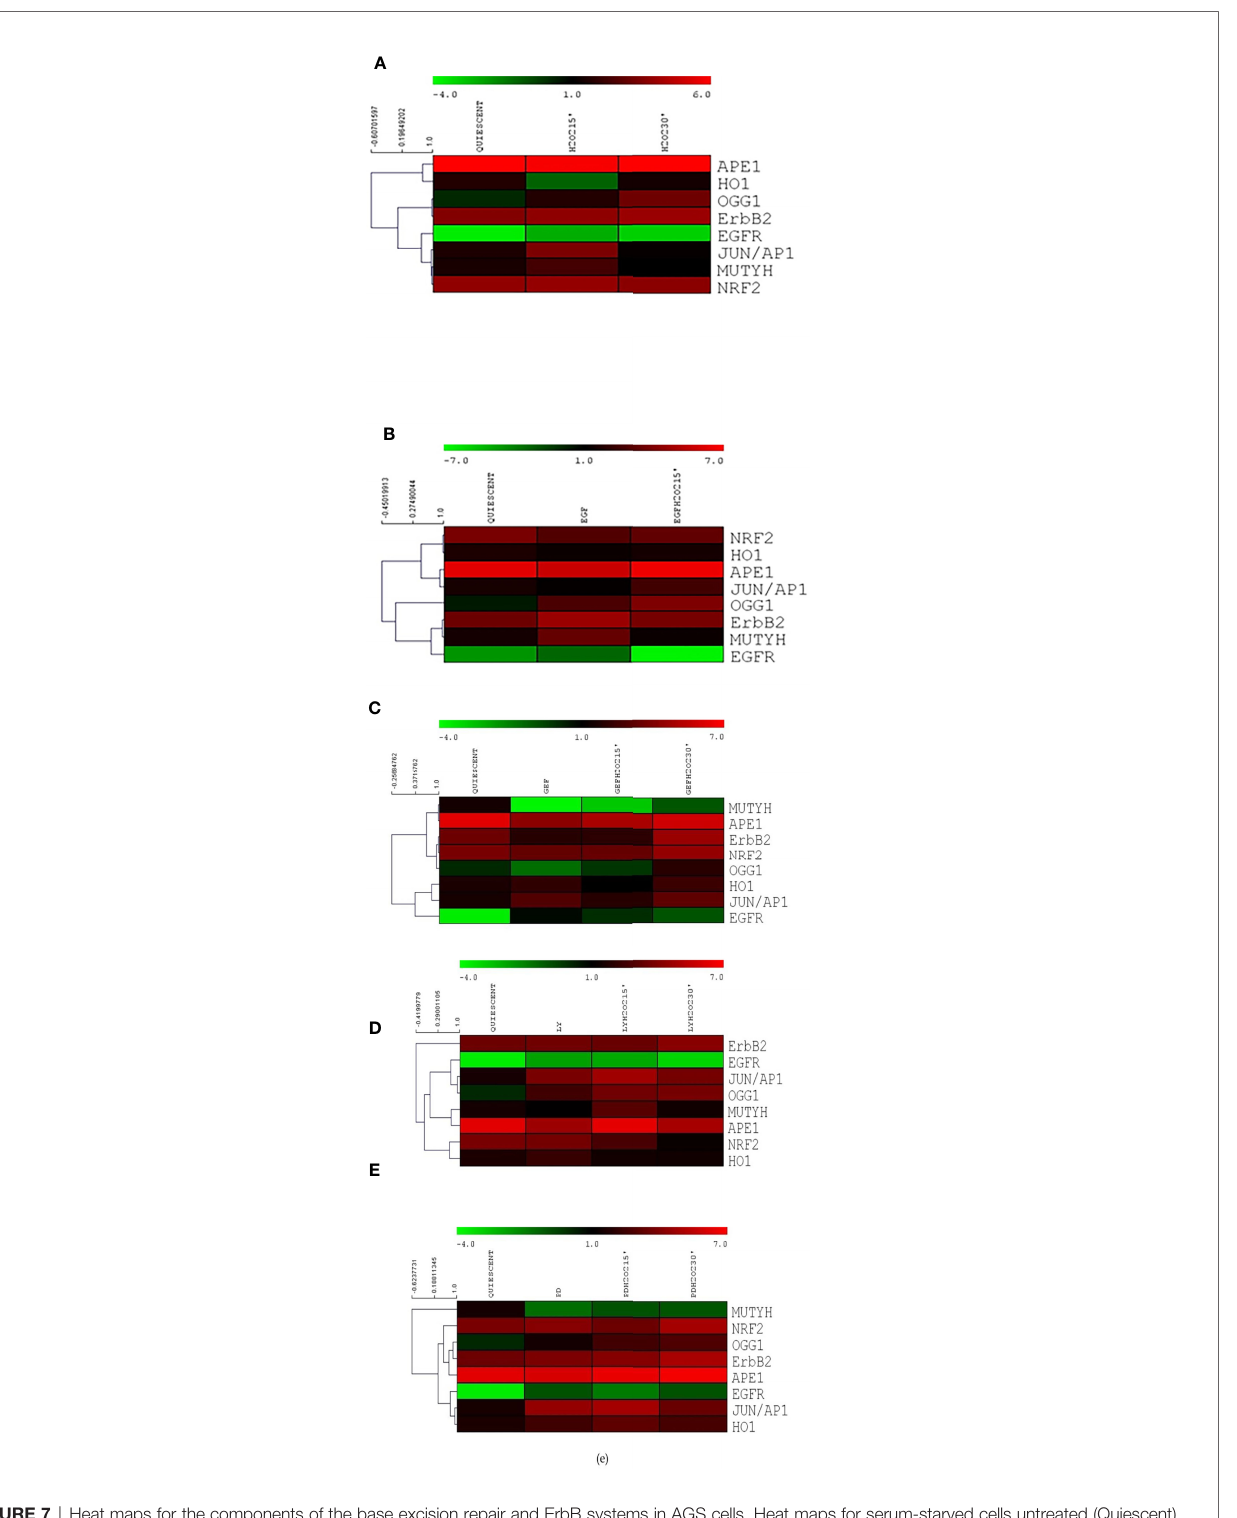
FIGURE 7 | Heat maps for the components of the base excision repair and ErbB systems in AGS cells. Heat maps for serum-starved cells untreated (Quiescent) and treated with 10 mM H 2 O 2 (A) , 50 ng/mL EGF (B) , 1 m M ge fi tinib (GEF) (C) , 25 µM LY294002 (LY) (D) , 50 µM PD98059 (PD) (E) , each (B-E) without and with 10 mM H 2 O 2 , for 15 and 30 min. Heat maps were constructed for expression of six genes related to base excision repair and EGFR and ERBB2 (as indicated). Top, color scale: red, increase in expression; green, decrease in expression. Left, cluster dendrogram for the Spearman R